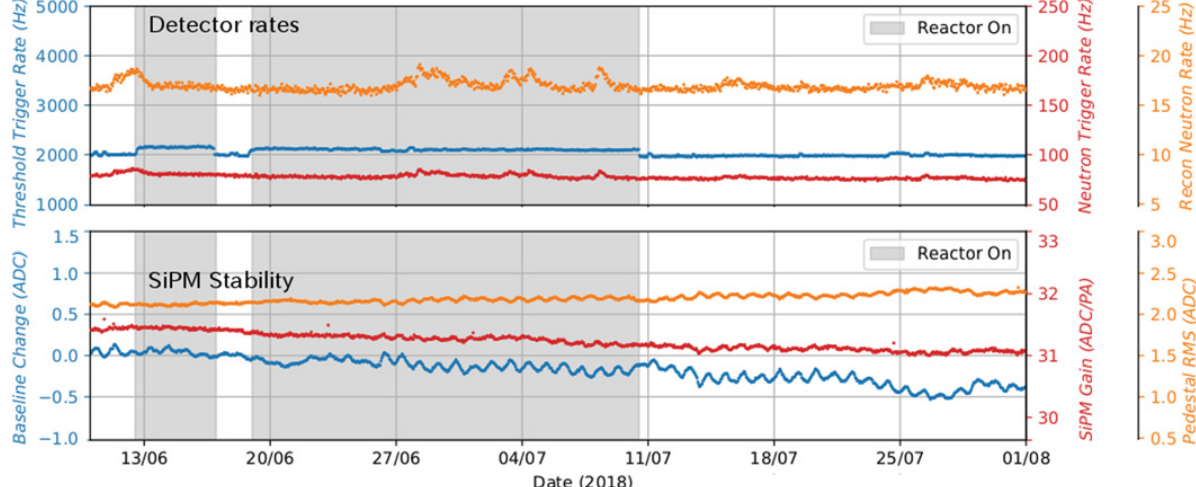
Figure 13. Weekly trends of various detector metrics. Only he threshold trigger rate is sensitive to the reactor on-off transition.